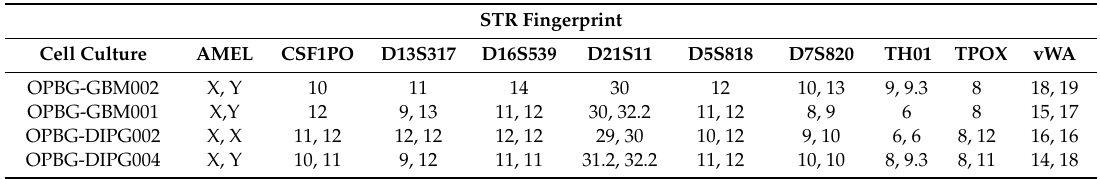
Table 5. Cell lines authentication